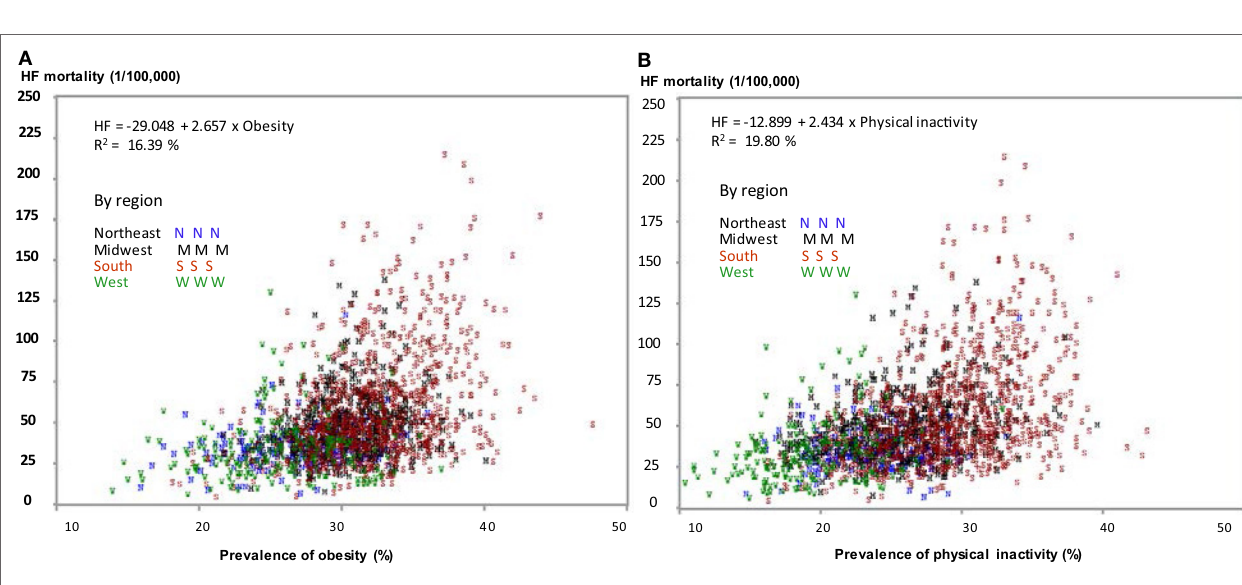
FigUre 5 | Correlation of age-adjusted prevalence of obesity (a) and physical inactivity (B) with age-adjusted heart failure (HF) mortality in 1,724 counties by